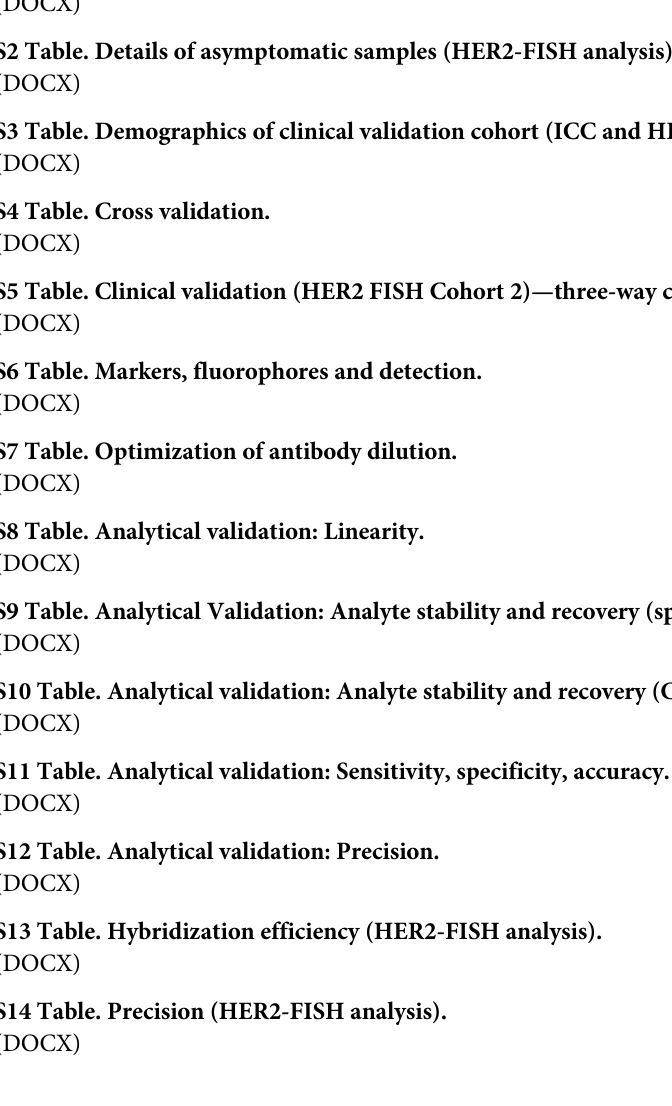
S3 Fig. Fluorescence Intensities of markers singly and in multiplexed combinations. S4 Fig. Detection thresholds. S5 Fig. Analytical validation: Linearity (ICC and